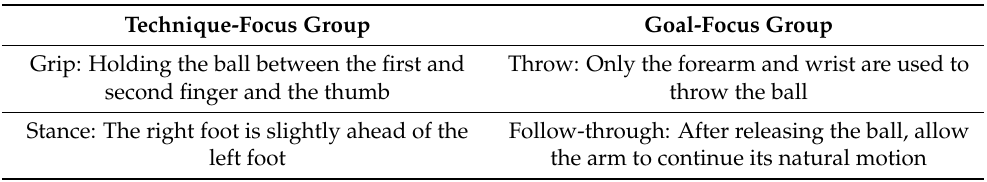
Table 4. Based on the group (technique-focus or goal-focus), different subcomponents of the PBT performance were shown in the video